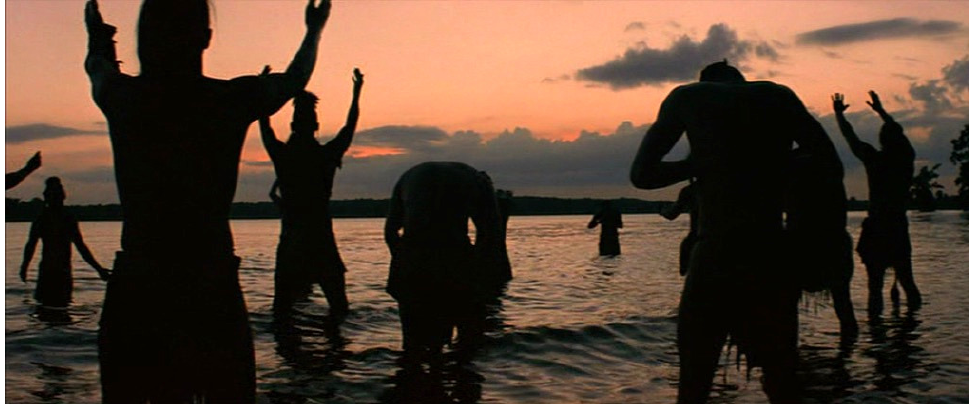
Figure 5: Indigenous tribesmen practice a water-involving, sky-directed salutation. These skyward gestures dramatise three of the four elements constitutive of dwelling: saving the earth, receiving the sky and awaiting divinities.